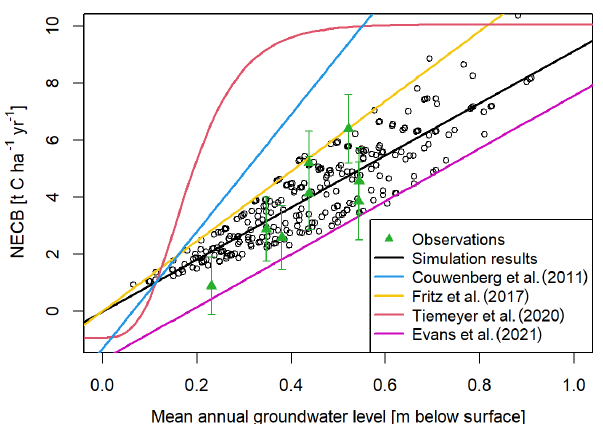
Figure 11. The relations between annual mean modelled groundwa- ter level and NECB found in this study in comparison with available fitted empirical relations to estimate NECB based on WTD a are pre- sented in Table 4. Observations from this research are also depicted with standard deviations.